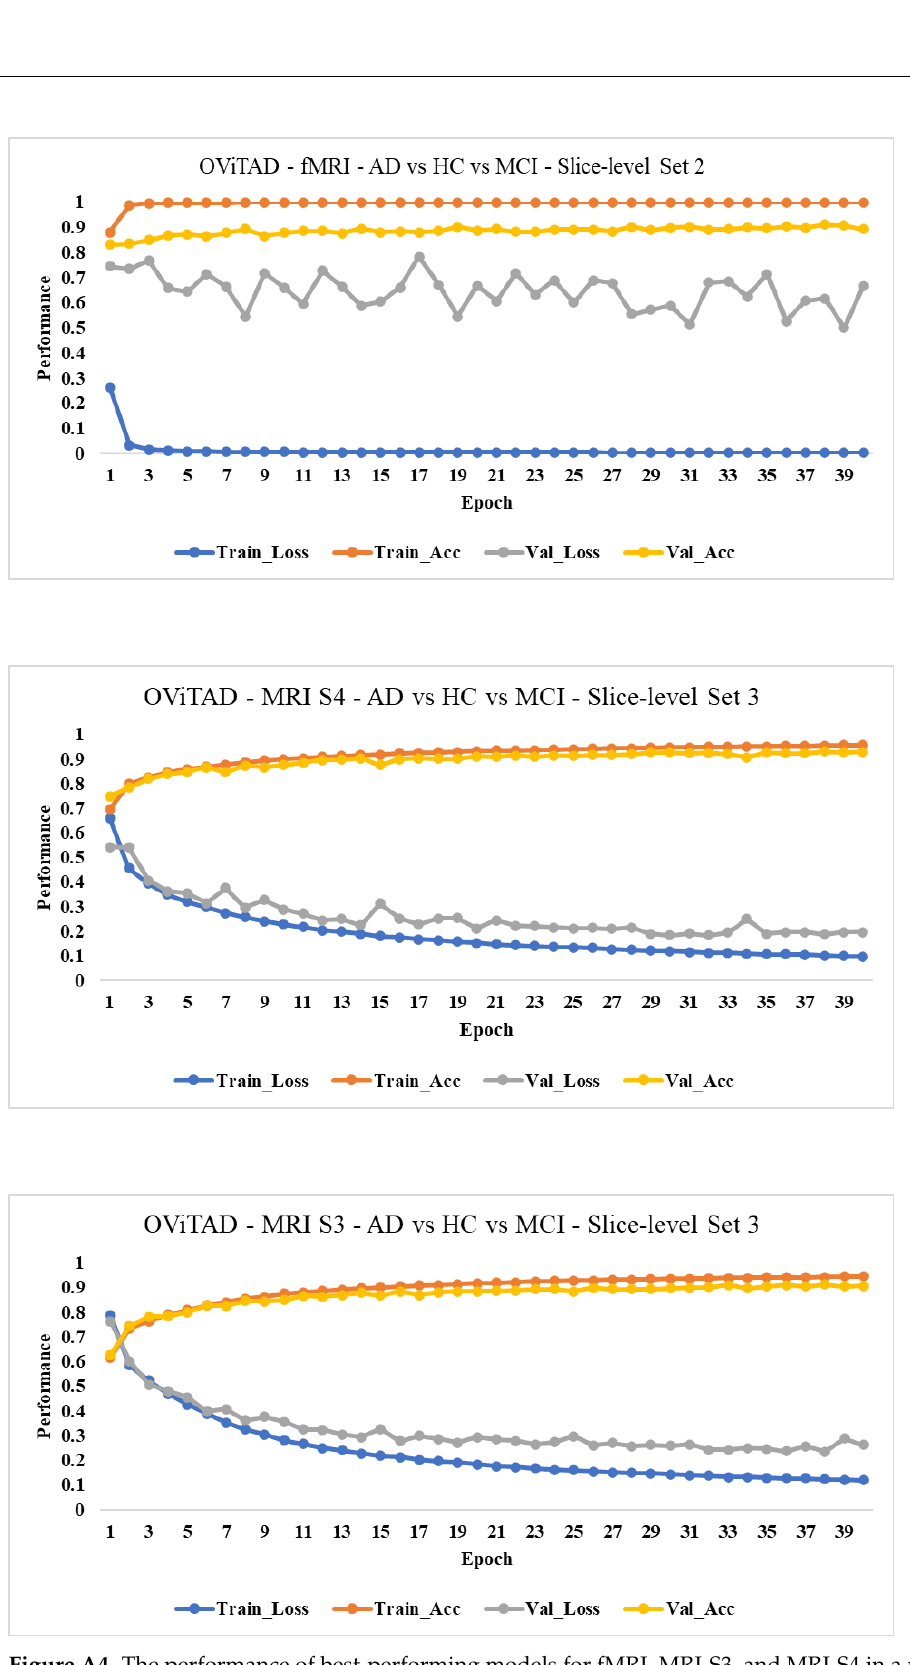
Figure A4. The performance of best-performing models for fMRI, MRI-S3, and MRI-S4 in a multiple classification experiment to predict AD vs. HC vs. MCI includes the training loss and accuracy rates and loss scores for training and validations sets. The modeling was conducted using 2D images, and the metrics shown across represent the slice-level performance used to extract the subject-level